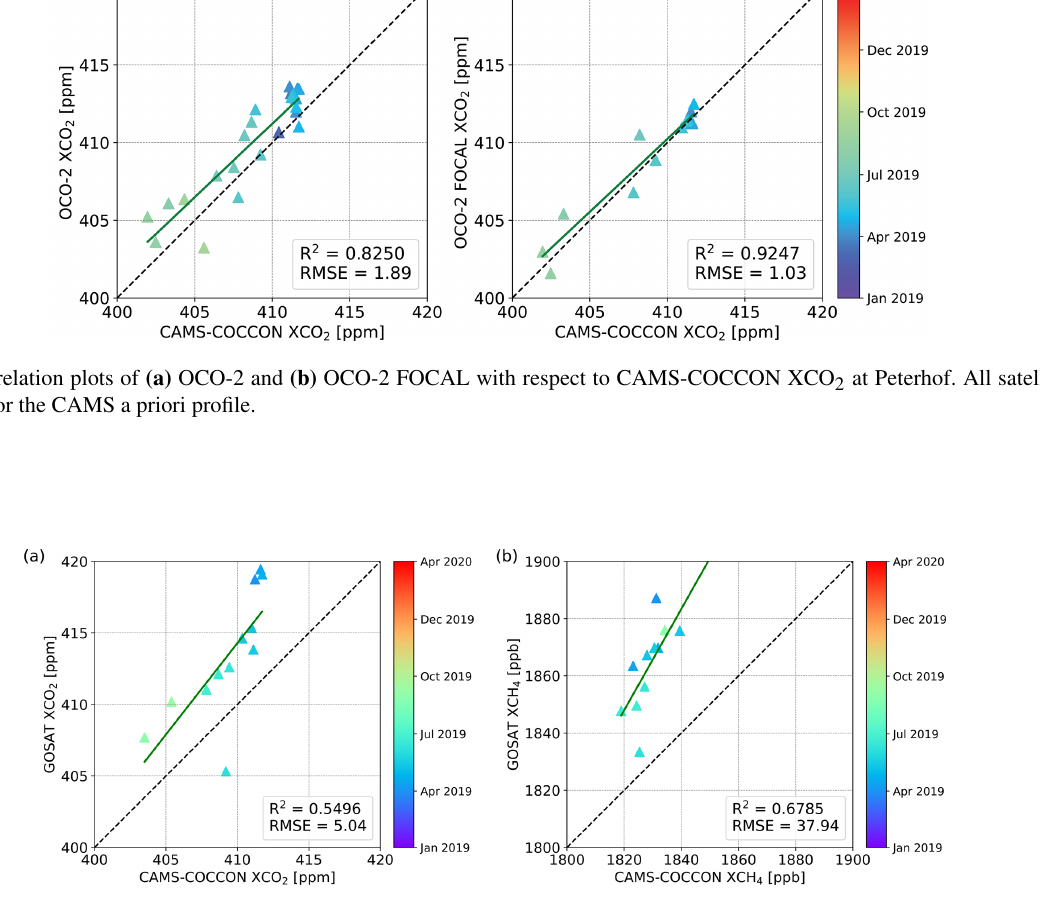
Figure 17. Correlation plots of (a) GOSAT XCO 2 and (b) GOSAT XCH 4 with respect to CAMS-COCCON at Peterhof. All satellite data were adjusted for the CAMS a priori profile.